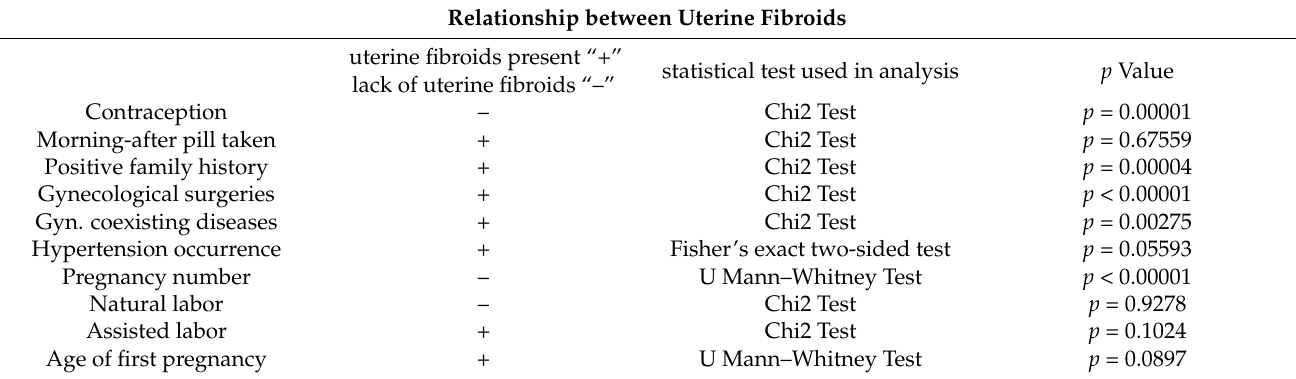
Table 4. Relationships concerning uterine myomas. Relationship between Uterine Fibroids